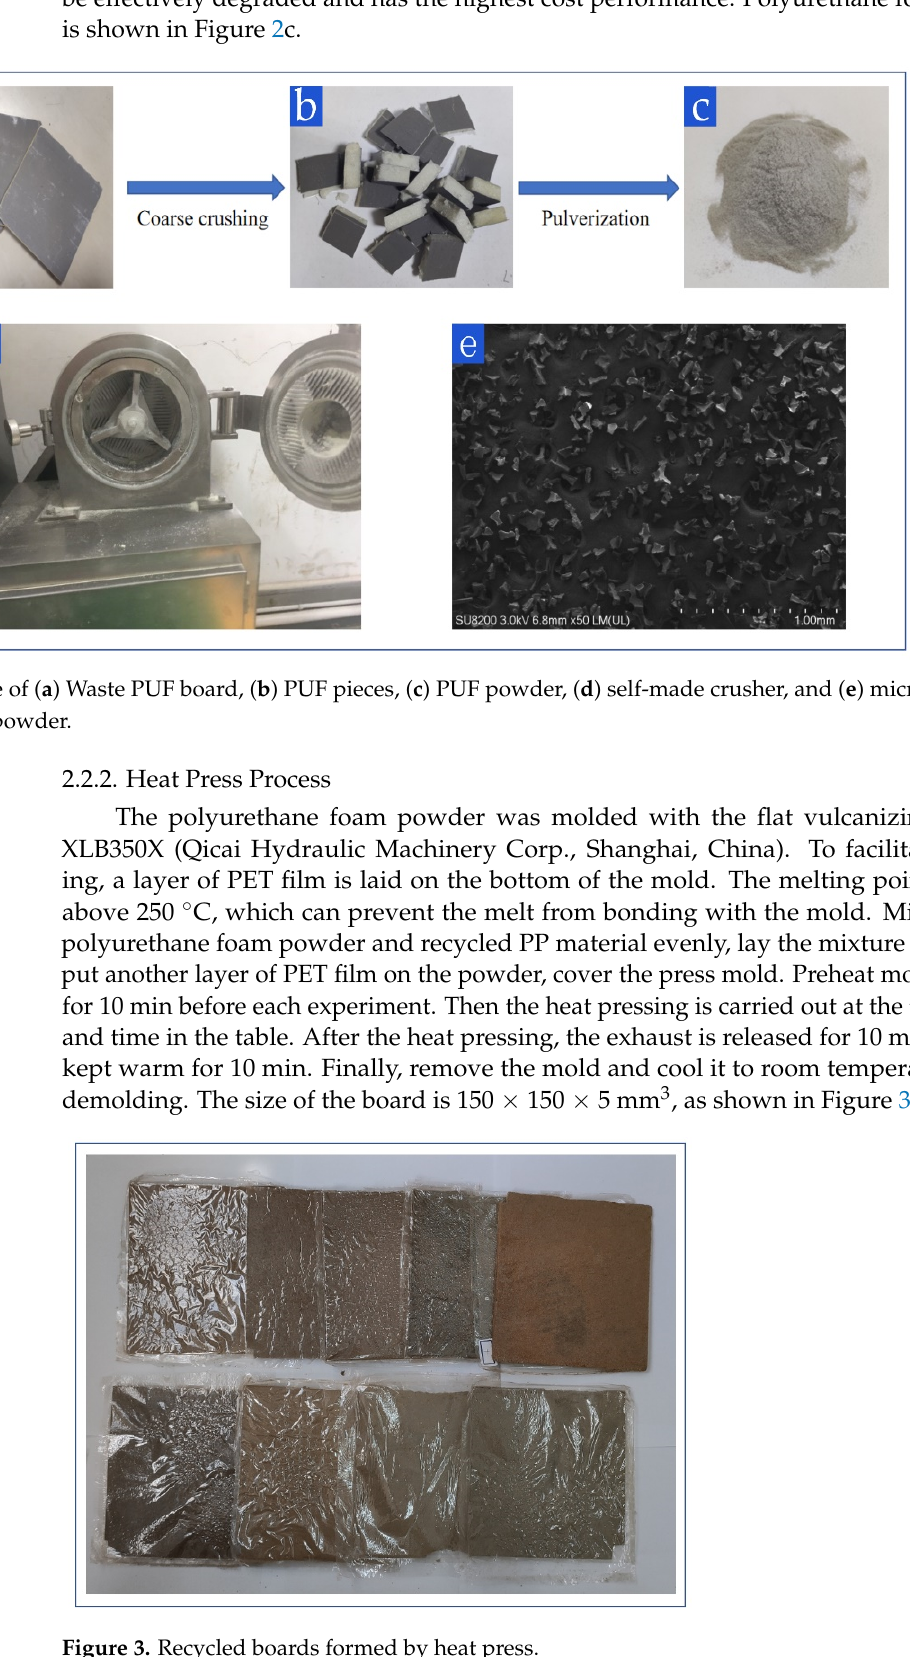
Figure 3. Recycled boards formed by heat